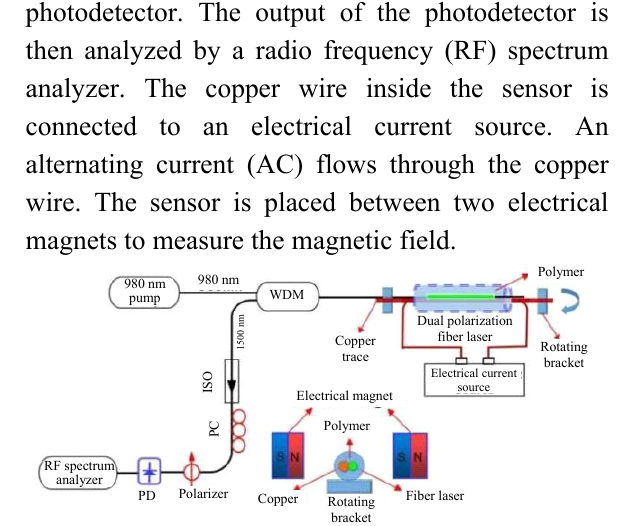
Fig. 2 Experimental setup for the proposed fiber-optic magnetic field sensor. (ISO: isolator; PC: polarization controller; PD: photodetector.)